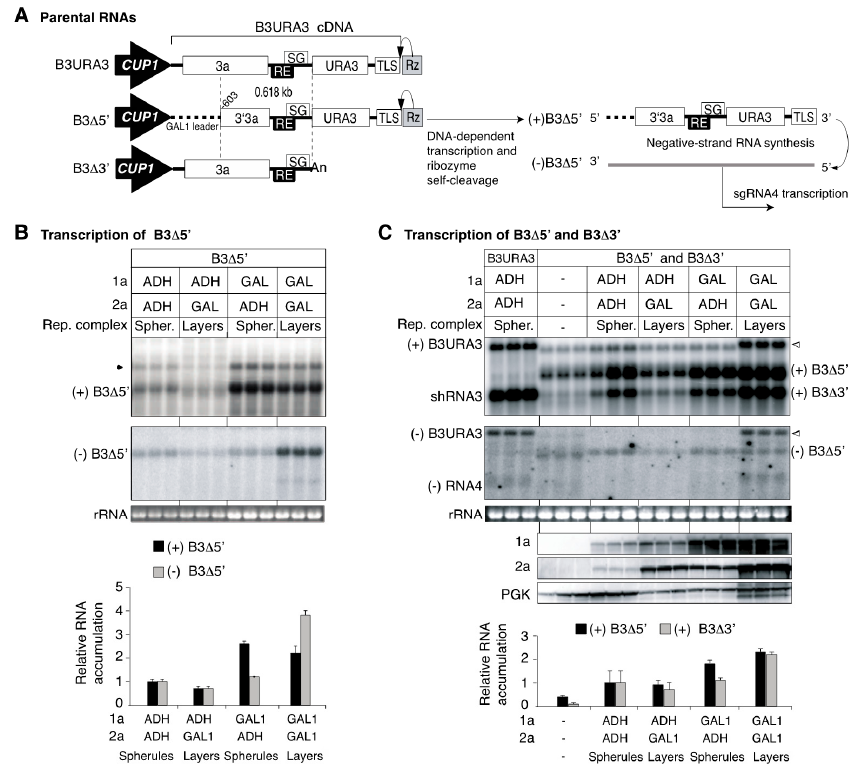
Figure 7. Accumulation of parental B3 Δ 5 ′ and B3 Δ 3 ′ in spherules and layers. ( A ) Features of CUP1 -driven B3 Δ 5 ′ and B3 Δ 3 ′ in relation to B3URA3. Labels are as in Figure 1A. Illustration of DNA-dependent transcription of B3 Δ 5 ʹ , ( − ) negative-strand RNA synthesis and subgenomic RNA4 transcription. ( B ) Accumulation of positive (+)- and negative ( − )-strand B3 Δ 5 ′ after transient transcription for nine yeast generations (72 to 96 h) in liquid cultures containing galactose and 500 μ M CuSO4. 1a and 2a pol were expressed from the ADH1 or the GAL1 promoter. The form of the BMV replication complex induced is indicated. Equal amounts of cells were harvested, and equal amounts of RNA analyzed by Northern blotting. Positive (+)- and negative ( − )- strand RNA was detected using a using a 32-P labeled probe targeting 3 ′ 3a or URA3, respectively. The black arrowhead points to transcripts that have not been cleaved by the ribozyme. Ethidium bromide staining of 18S rRNA is indicated at the bottom. The histogram illustrates B3 Δ 5 ′ accumulation in each condition relative to ADH1 spherules. Bars represent the average and standard error of three biological replicates. Positive-strand B3 Δ 5 ′ accumulated to higher levels ( p < 0.01) in GAL1 spherules and GAL1 layers than in other conditions. Negative-strand B3 Δ 5 ′ accumulated to higher levels ( p < 0.01) in GAL1 layers that in other conditions. ( C ) Accumulation of positive (+)- and negative ( − )-strand B3 Δ 5 ʹ and B3 Δ 3 ʹ , and replication proteins. Cultures were grown and samples were processed as in ( B ) except that duplicate samples were collected for total RNA or protein extraction. B3URA3 was included as size marker. (+) B3URA3 and (-) B3URA3 indicate B3URA3 of positive and negative polarity, respectively. shB3URA3 is a transcript formed after premature termination of transcription at the oligo (A) tract (Sullivan and Ahlquist, 1999) and is approximately the same size as B3 Δ 3 ′ . Empty arrowheads point to intermolecular RNA recombinants matching the size of B3URA3. The middle panel shows accumulation of replication proteins 1a and 2a pol in conditions inducing the formation of spherules or layers. 1a and 2a pol were detected by immunoblotting, and 3-phosphoglycerate kinase (PGK) was used as loading control. The histogram illustrates B3 Δ 5 ′ or B3 Δ 3 ′ accumulation in each condition relative to ADH1 spherules. Bars represent the average and standard error of three biological replicates. Positive-strand B3 Δ 5 ′ accumulated to higher levels ( p < 0.01) in GAL1 spherules and GAL1 layers that in other conditions. Positive-strand B3 Δ 3 ′ accumulated to higher levels ( p < 0.01) in GAL1 layers than in other conditions.